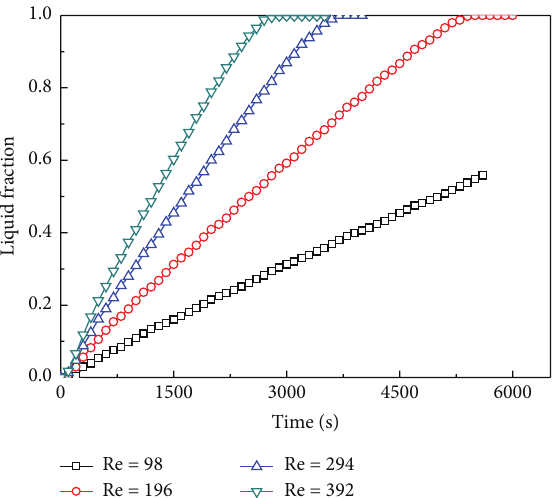
Figure 15: Pressure drop calculated for the heat exchanger unit.